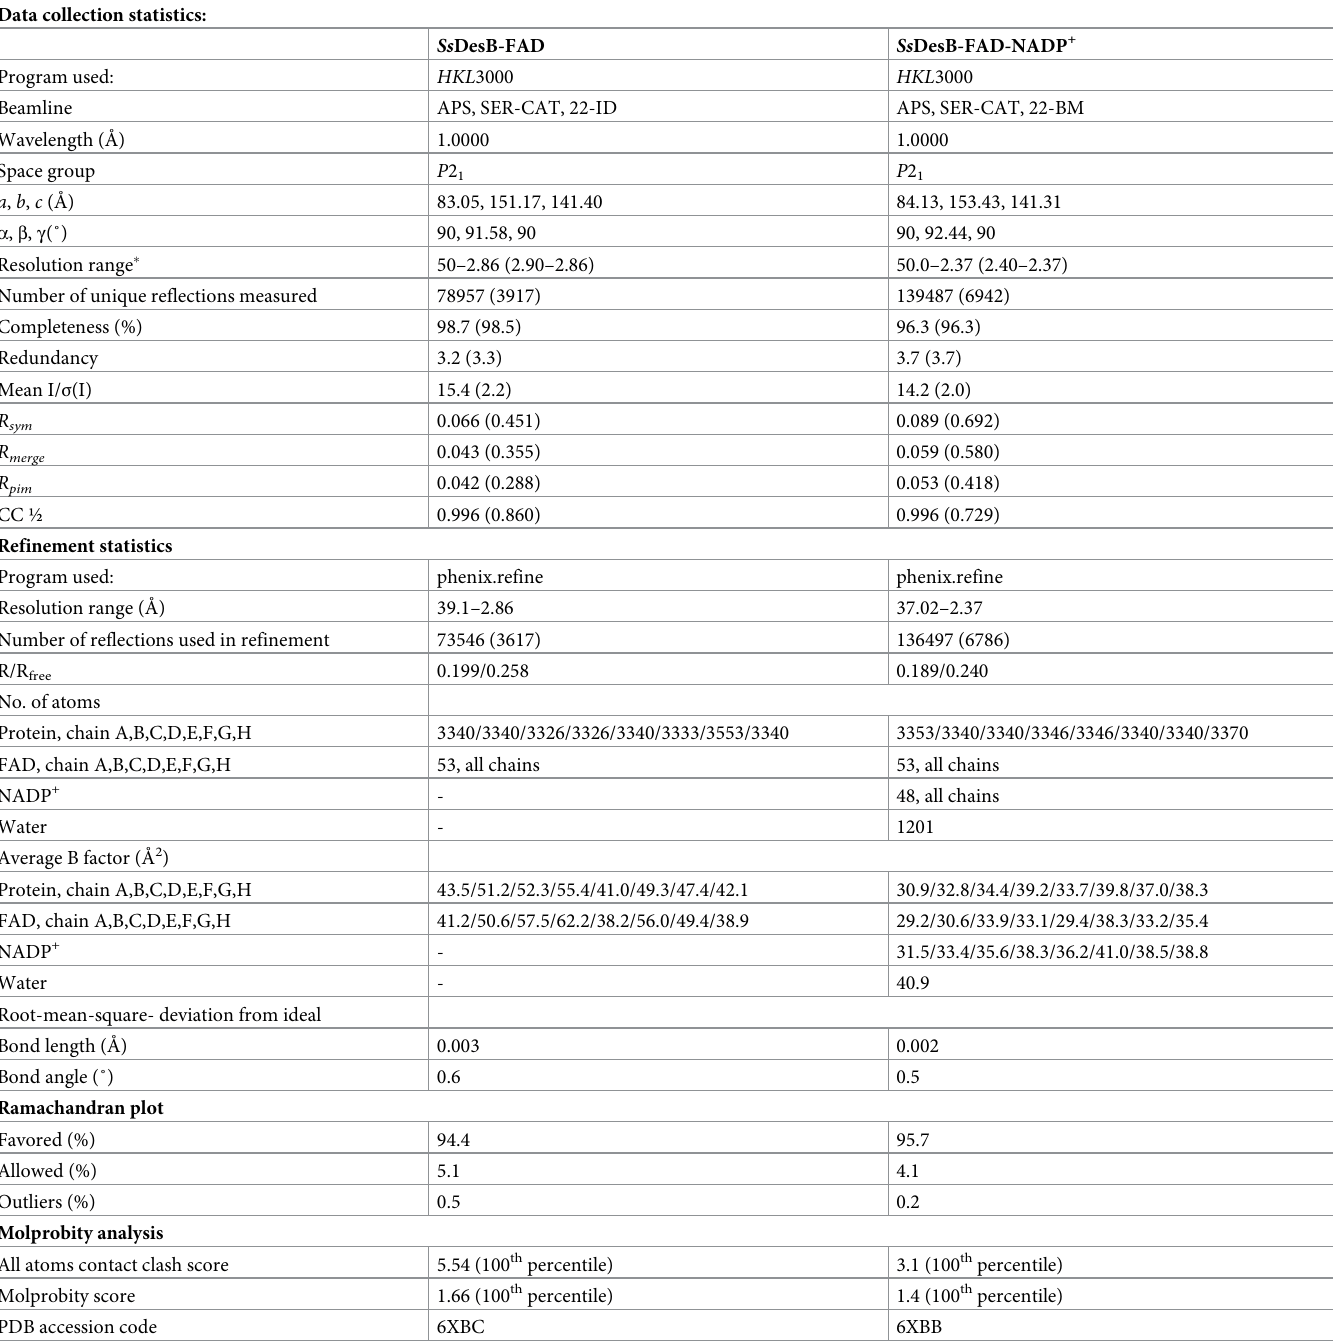
Table 4. Crystallographic data collection and refinement